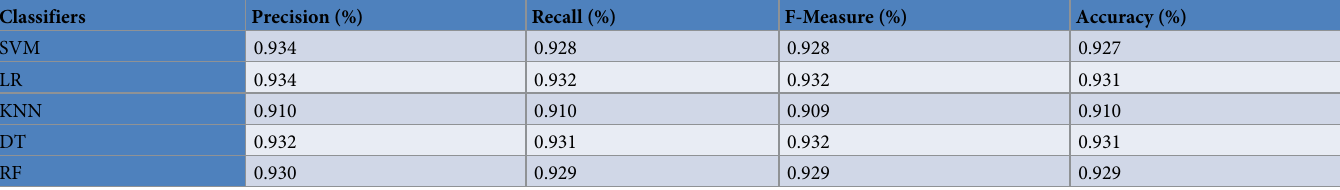
Table 9. Performance results obtained by considering fused